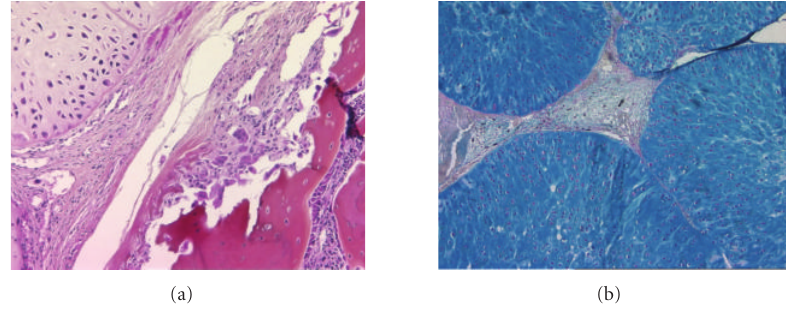
Figure 4: Histomorphological features of the SRC model at study end showing: (a) a tumoural tissue with hypercellularity, and bone osteolysis (x10); (b) a high density of blue Alcian stained areas as a reflect of proteoglycan content (x5).